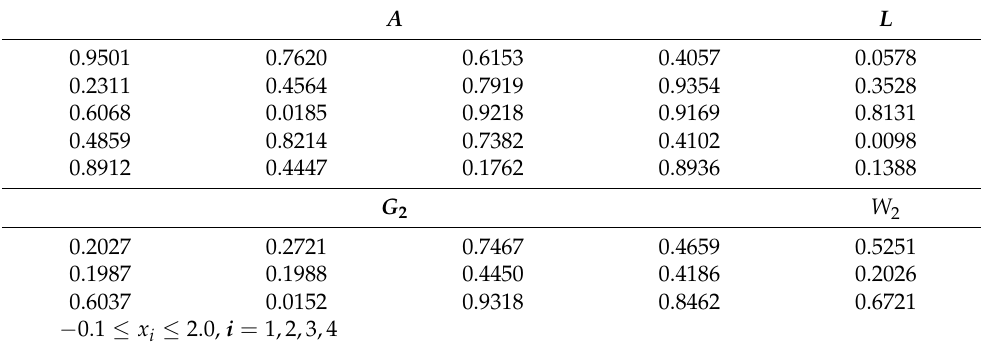
Table 4. Data from Zhang et al. (2013)